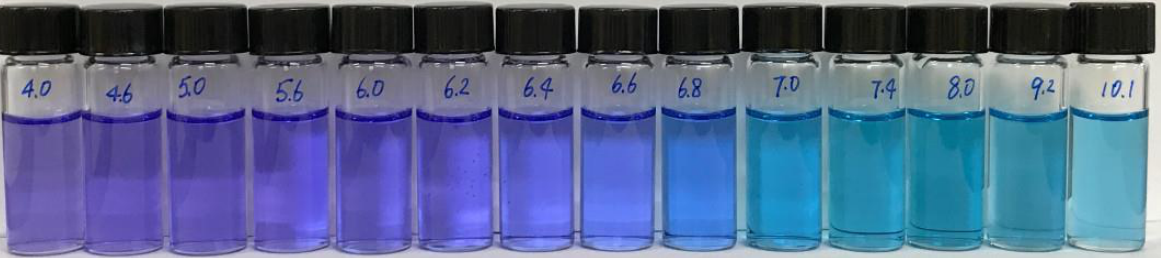
Figure 1. Absorption spectra of 10 µM probes AH + ( A ) and BH + ( B ) in PBS buffers with pH changes from 4.0 to 10.1, respectively.